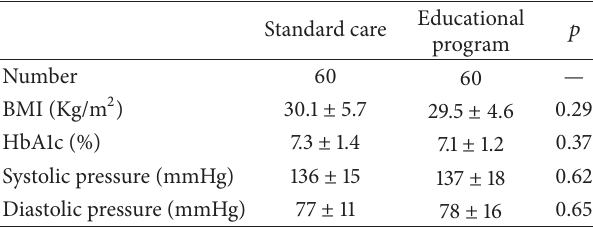
Table 2: Selected clinical parameters at 6-month follow-up.